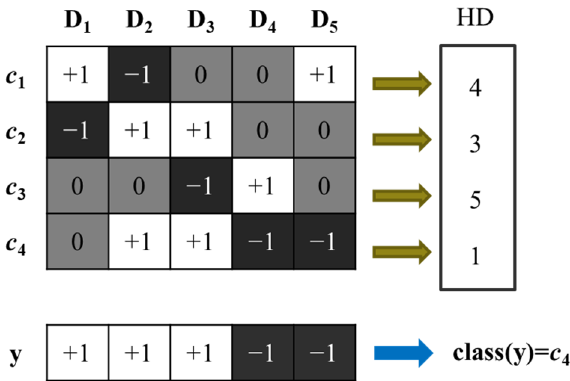
Figure 5. The decoding process of ECOC algorithm.